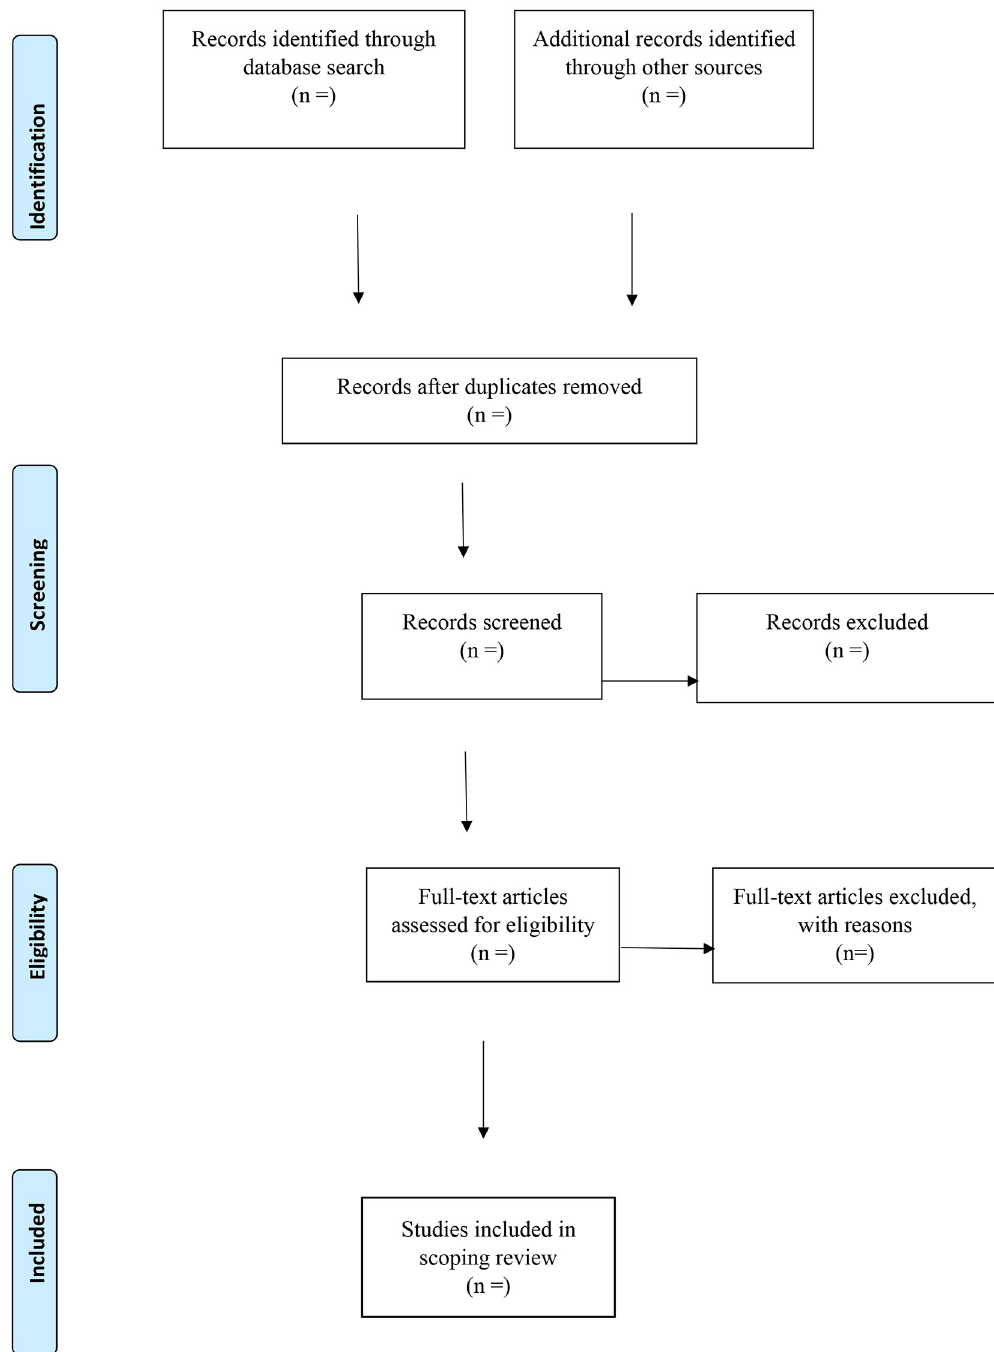
Fig 1. PRISMA flow-chart. [Source: Adapted from Moher et al. [14]].